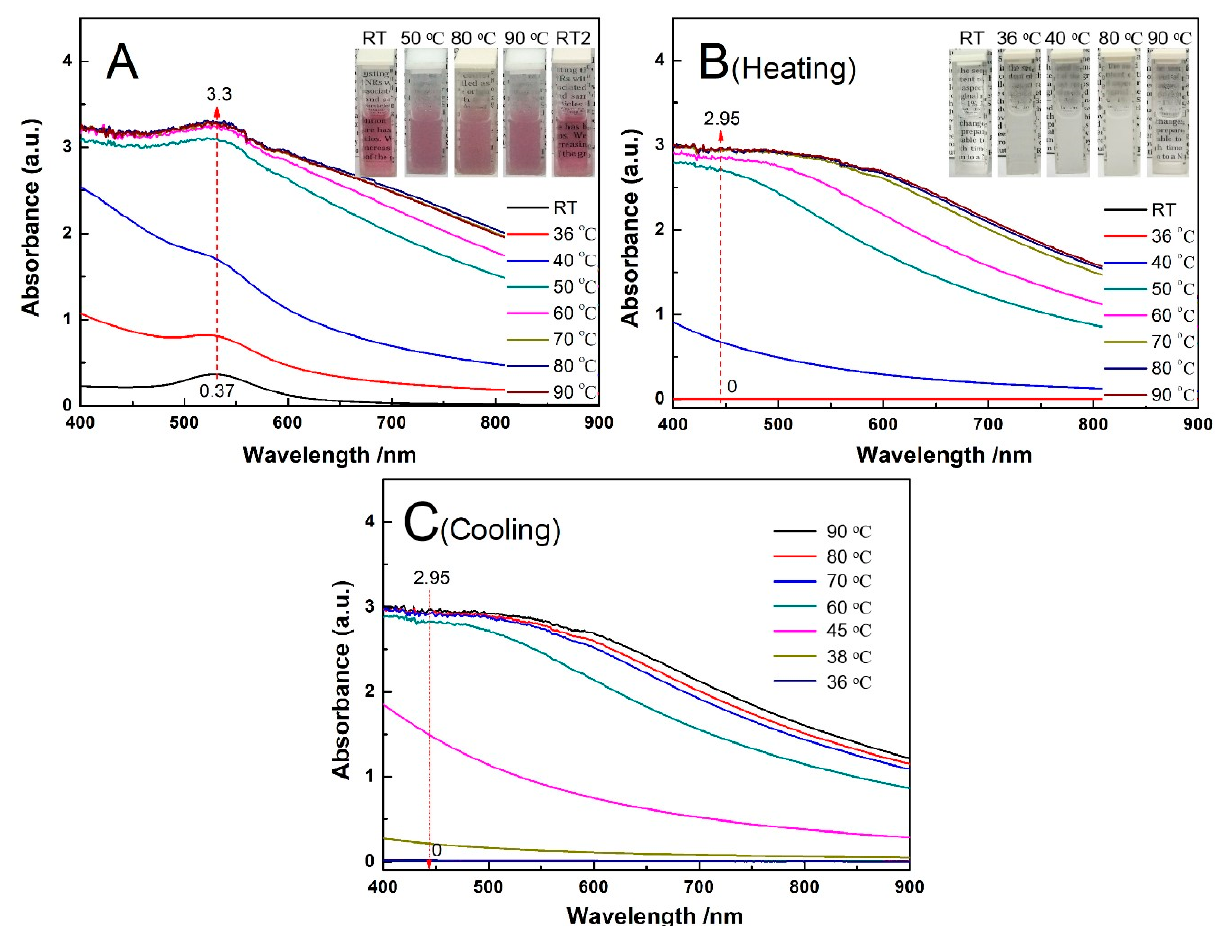
Figure 5. The change in the UV-Vis spectra with temperature for AuNPs-PNIPAM/PNIAM ( A ) and the supernatant from centrifugation of AuNPs-PNIPAM/PNIAM ( B , C ) in the presence of 16.9 mM of NaCl.